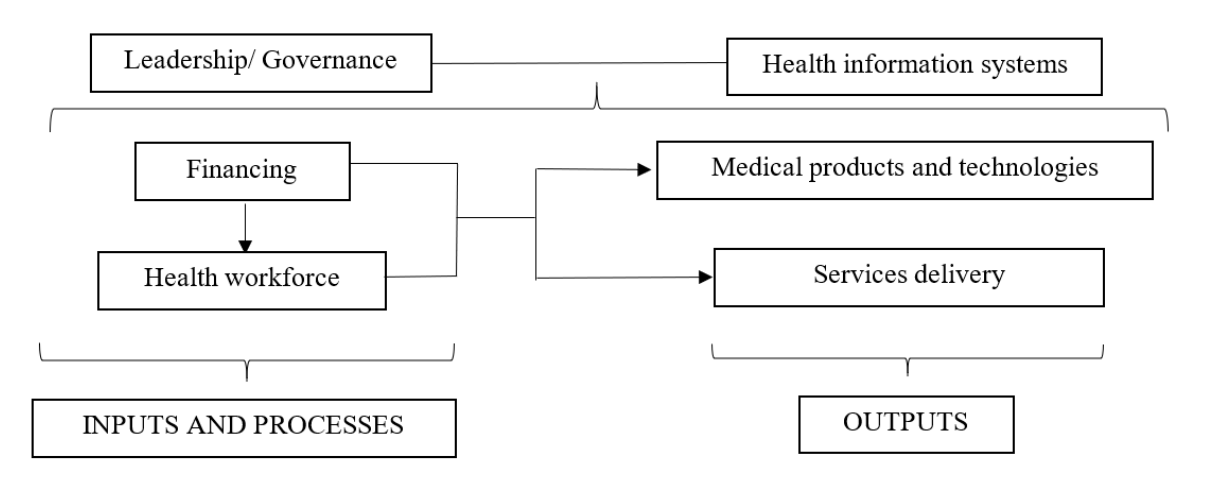
Figure 1. Health system strengthening: relationship between the World Health Organization building blocks (6 core components, top) and International Health Partnership monitoring and evaluation framework (inputs, processes and outputs,